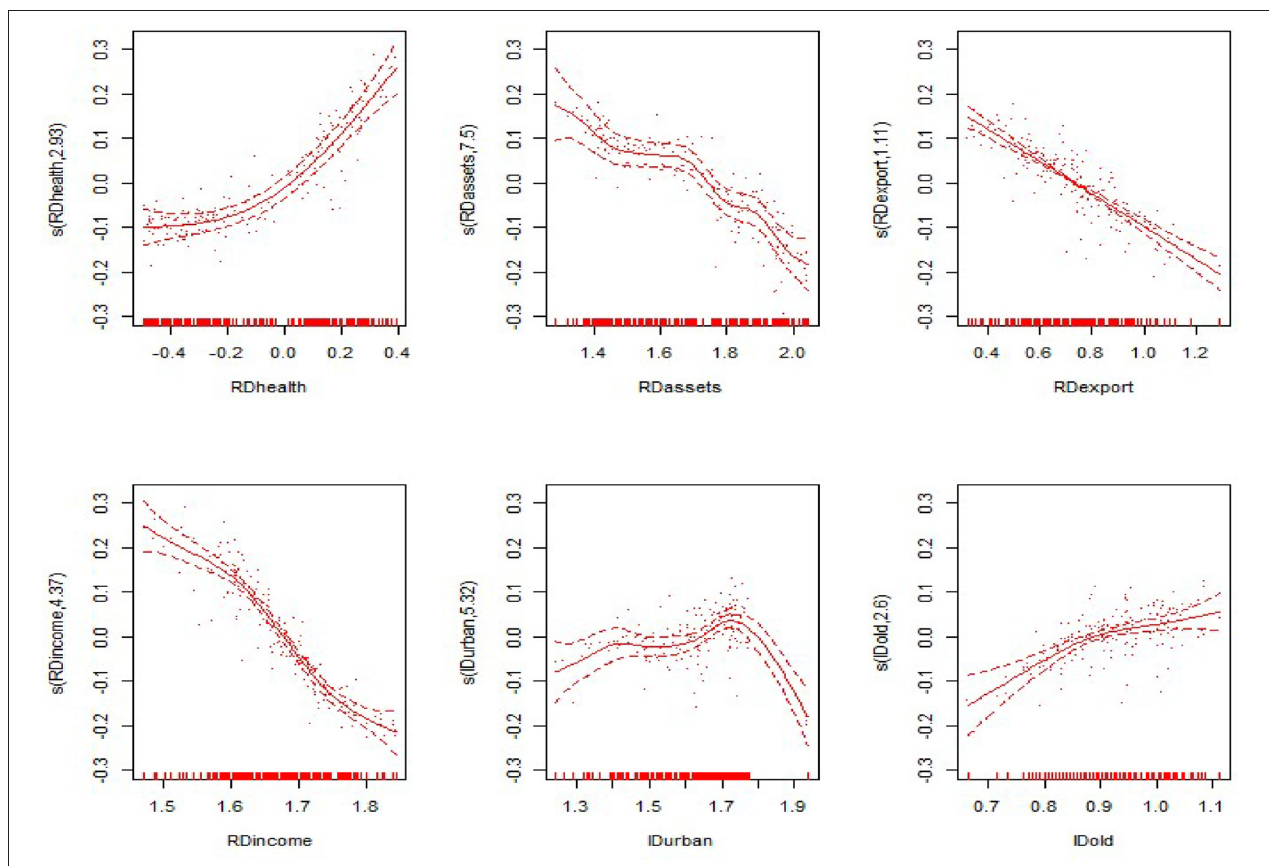
FIGURE 5 | Non-linear effects of the explanatory variables on per capita GDP in the central